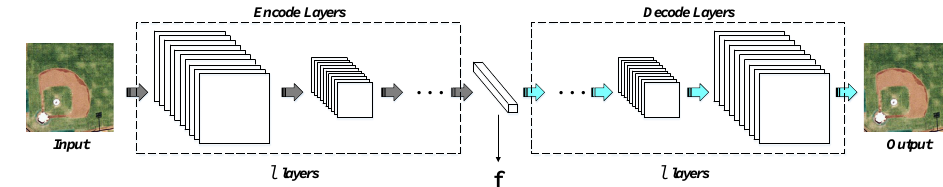
Figure 7. Framework of the utilized deep convolutional